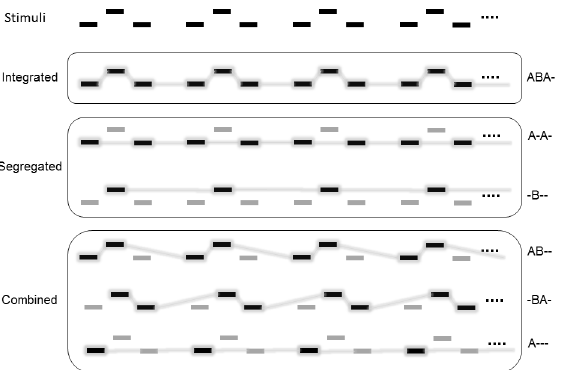
Fig 1. Schematic depiction of the auditory streaming paradigm (top panel) and its possible perceptual interpretations grouped into 3 categories (the 3 lower panels). Rectangles depict the “ A ” and “ B ” sounds with the feature difference between them indicated by displacement in the vertical direction. Time flows along the horizontal direction. Sounds perceived as part of the same stream are connected by lines in the lower panels. Darker notes with grey background indicate the stream in the foreground (also described with symbols to the right of each of the lower panels).